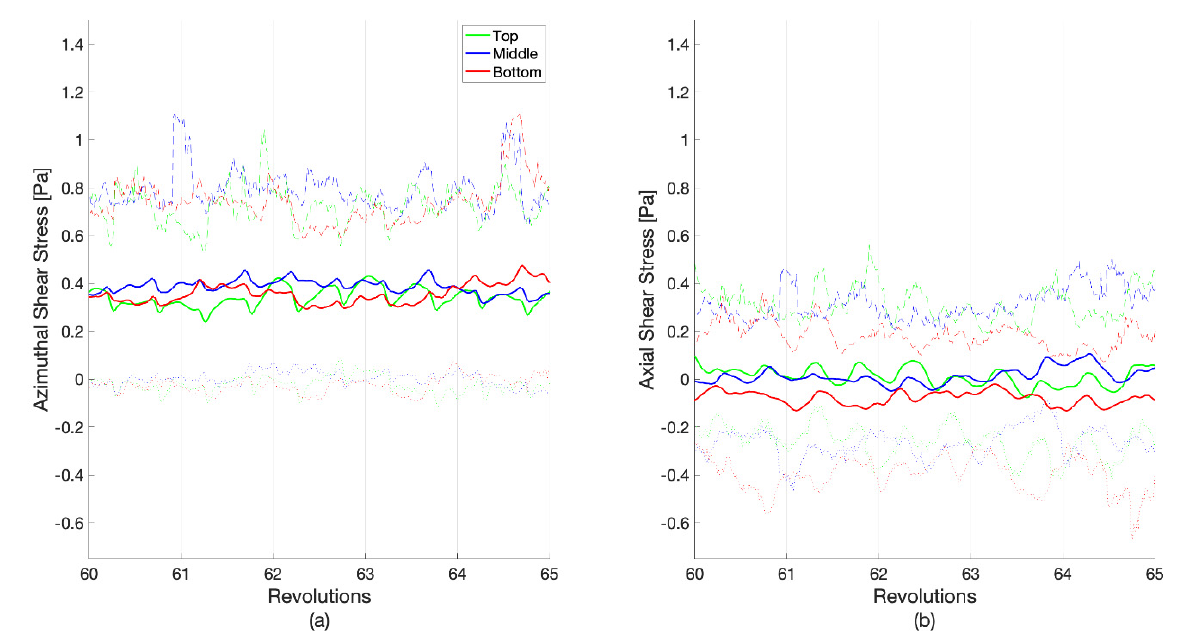
Figure 7. A zoomed-in portion of Figure 6 between revolutions 60 and 65, where the ( a ) azimuthal and ( b ) axial vector components are presented. The coupon averages (bold), maximums (dashed), and minimums (dotted) are shown. The average shear stress is area weighted by the element area.